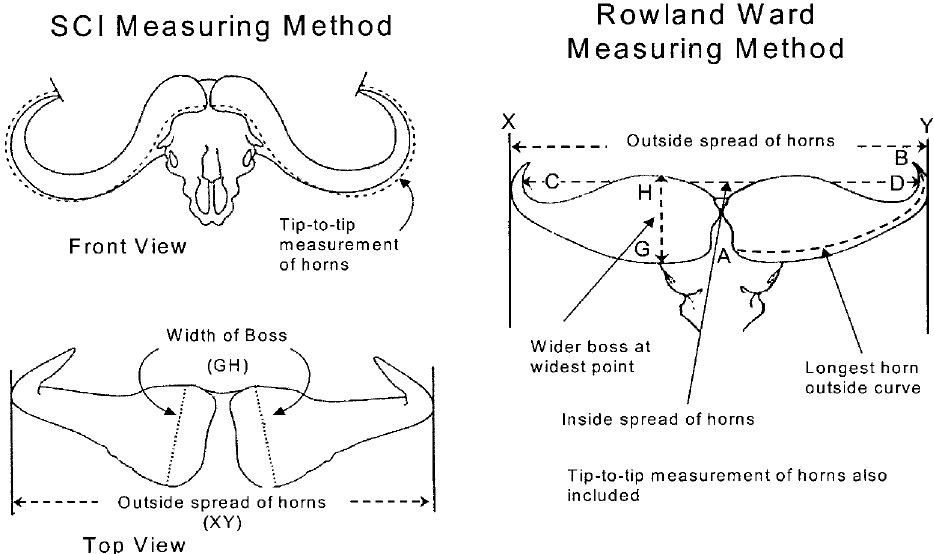
Fig. 1. Diagrammatical representation of the current measuring methods as applied by Safari Club Interna- tional and Rowland